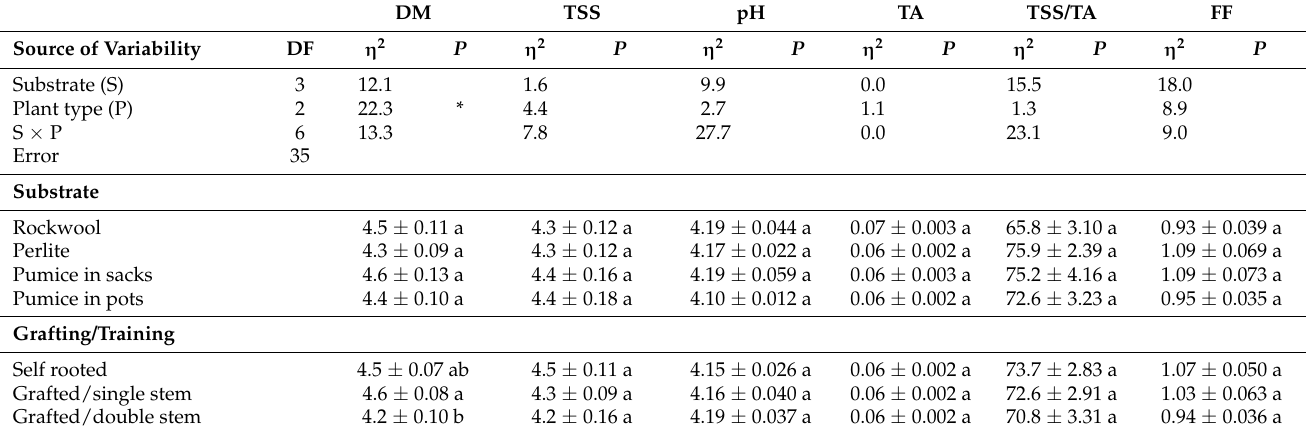
Table 9. Analysis of variance for average flavor quality traits (dry mass: DM, total soluble solids: TSS, titratable acidity: TA, flesh firmness: FF) of tomato fruit harvested on 6 November. The fruit was obtained from self-rooted ‘Beef Bang F1’, ‘Beef Bang F1’ grafted onto ‘Defensor’, trained in single or double stem and grown hydroponically in four substrates (rockwool slabs, perlite in sacks, pumice in sacks and pumice in pots) in a glasshouse.